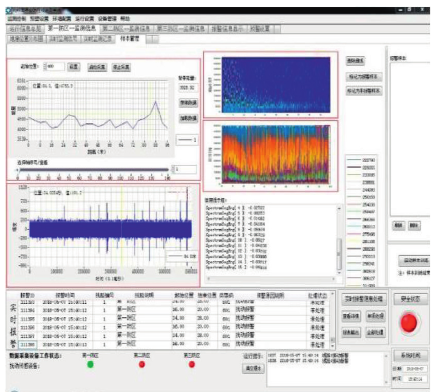
Figure 10: Offline monitoring part interface